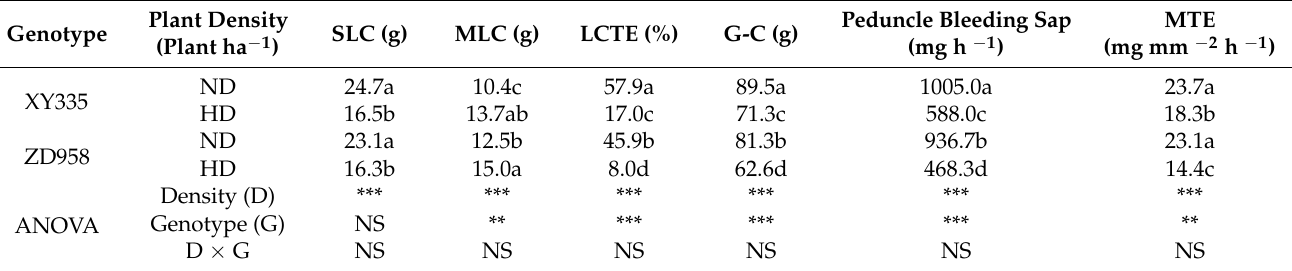
Table 3. Effect of plant density on the leaf and grain C contents, mean grain filling rate, and matter transport efficiency in two maize hybrids grown in 2018.